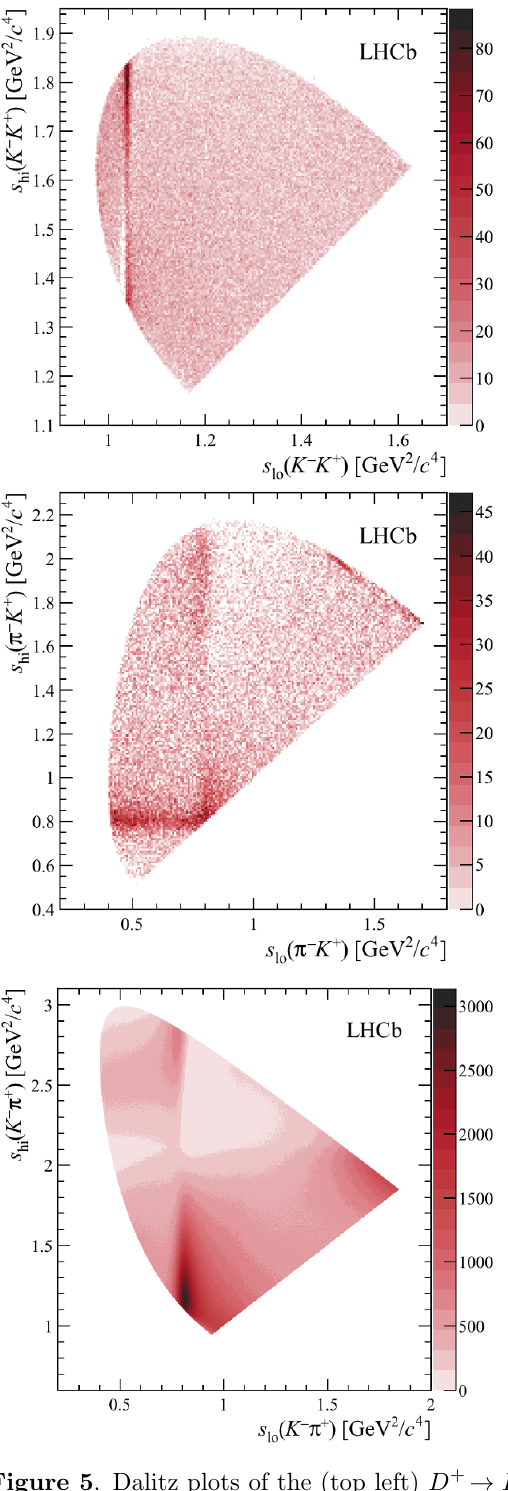
! (cid:25) (cid:0) K + K + , (middle right) D + ! K (cid:0) K + (cid:25) + , (bottom left) s ! K (cid:0) K + (cid:25) + decays, with signal weights from sPlot . A s ! K (cid:0) K + (cid:25) + channels. s